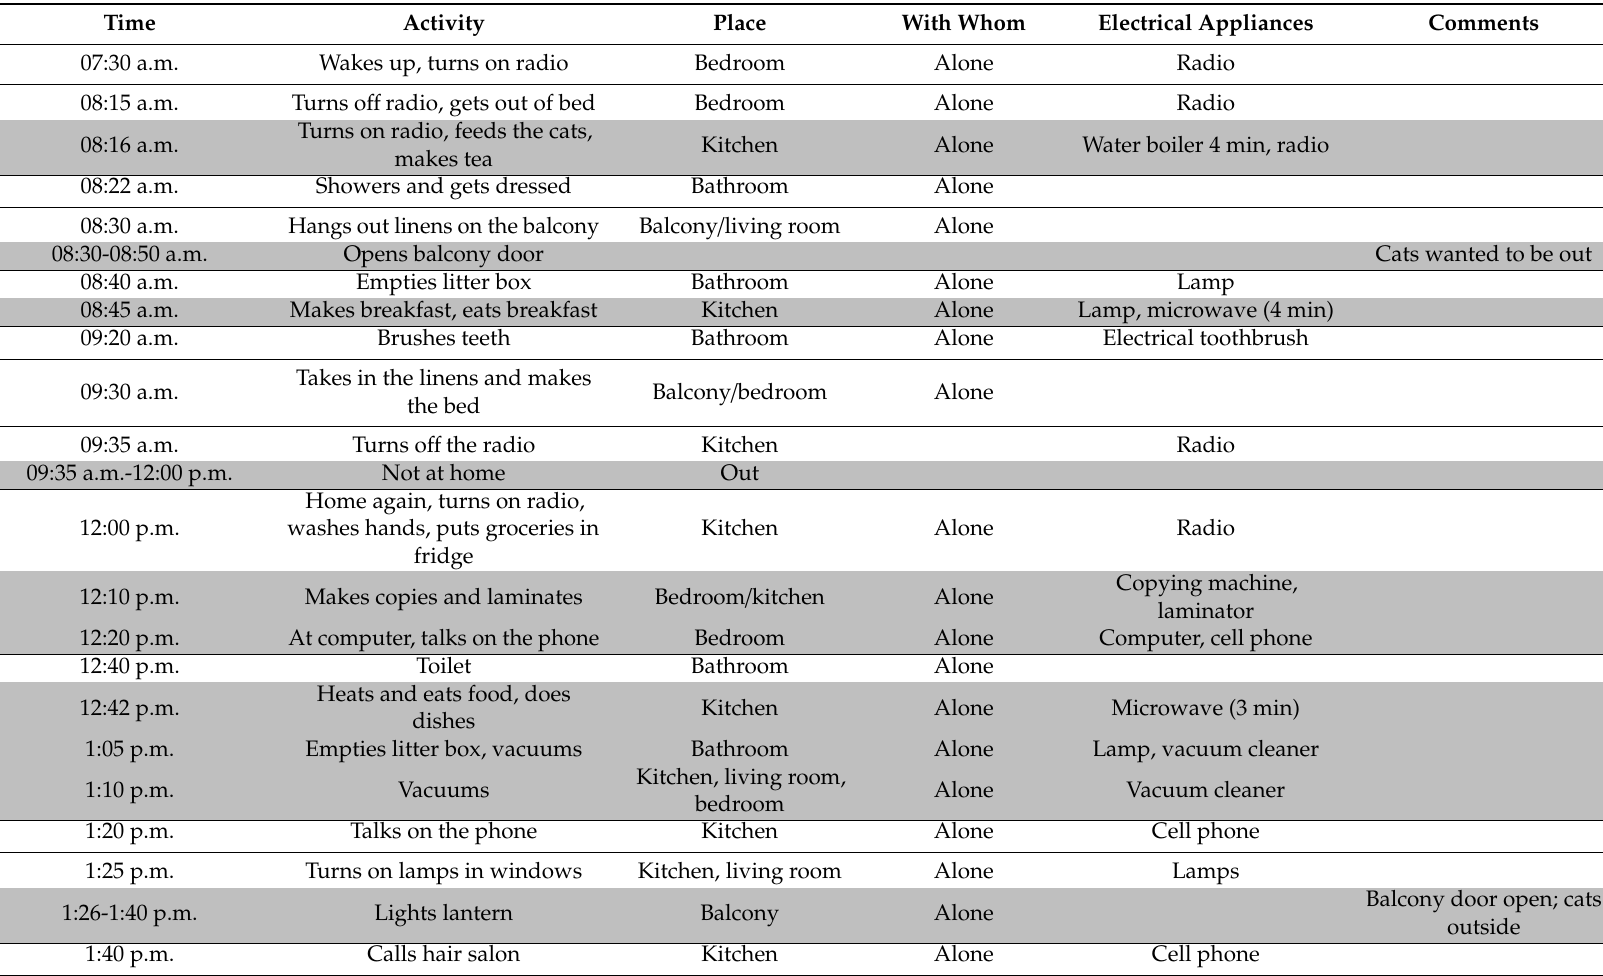
Table 8. Transcribed time diary from tenant in apartment 5, second floor, on 19 November. The e ff ects of entries on the gray background are clearly visible in the logged measurements in Figure